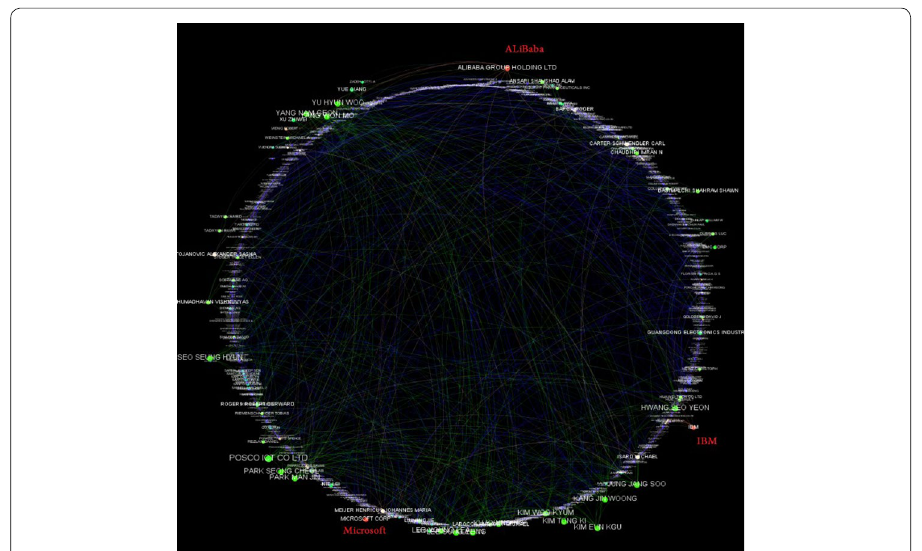
Fig. 12 Network of co-applicants of major jurisdictions except China. As the size of nodes and the line of edges show there is not a significant difference among the applicants in terms of their interaction. We highlighted IBM, Microsoft and Alibaba manually